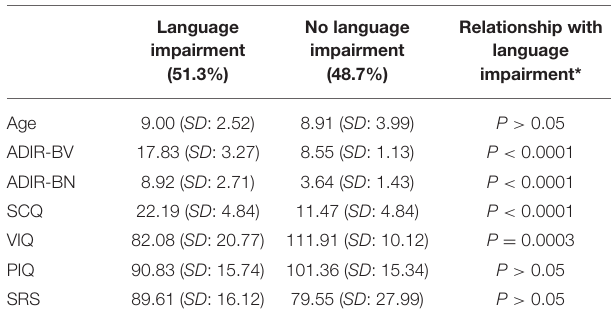
TABLE 1 | Clinical features of the patients in the current study.